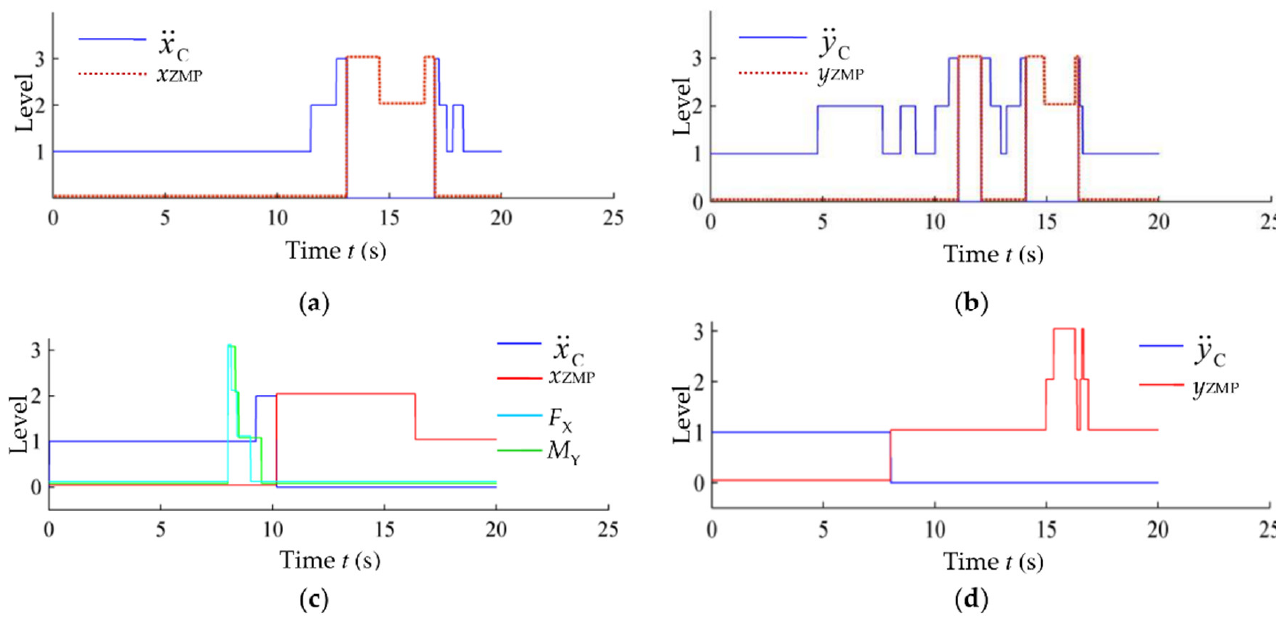
Figure 14. Action switching of the global self-stabilizer during single-leg stance. ( a ) Action switching on the x -axis without impact; ( b ) action switching on the y -axis without impact; ( c ) action switching on the x -axis with impact; ( d ) action switching on the y -axis with impact.